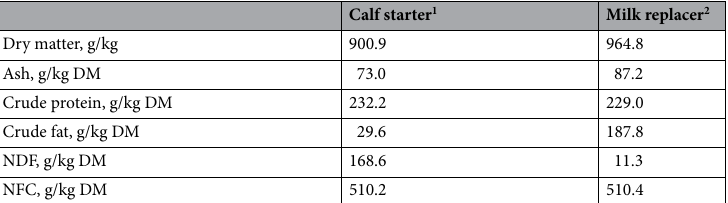
Table 4. Chemical composition of the calf starter and milk replacer. 1 Ag Milk Agroceres Multimix Nutricao Animal Ltda., Rio Claro, SP, Brazil; 2 Sprayfo Azul, Sloten from Brazil Ltda, SP, Brazil: 25,000 UI Vit A, 5000 UI Vit D3, 336 UI/kg Vit E, 300 μg/kg Se, 10 mg/kg Cu and 90 mg/kg of Fe; Ingredients composition: Whey, lactose-free whey, concentrated whey protein, lipids of vegetable origin, hydrolyzed wheat gluten, folic acid, calcium pantothenate, vitamins (A, D3, E, K, C, B 1 , B 2 , B 6 , B 12 ), biotin, niacin, iron sulfate monohydrate, copper sulfate pentahydrate, magnesium sulfate, manganese sulfate monohydrate, sodium selenite, potassium iodide, zinc sulfate monohydrate, probiotic additive; NDF Neutral detergent fiber, NFC Nonfiber